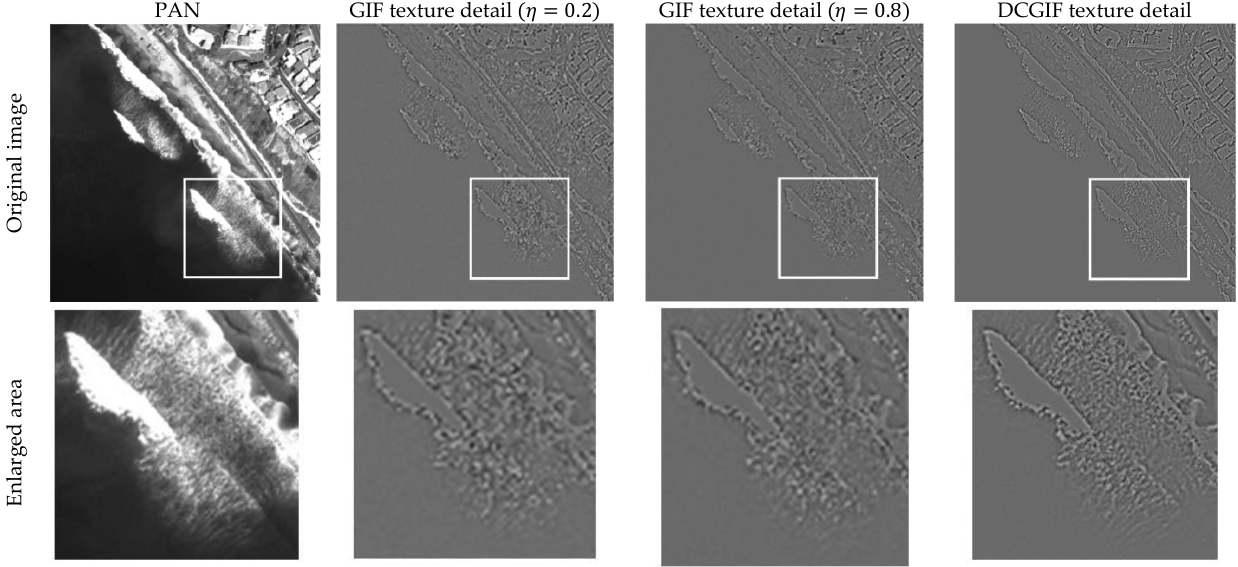
Figure 7. Comparison of GIF and DCGIF models extracting spatial detail information from PAN image.